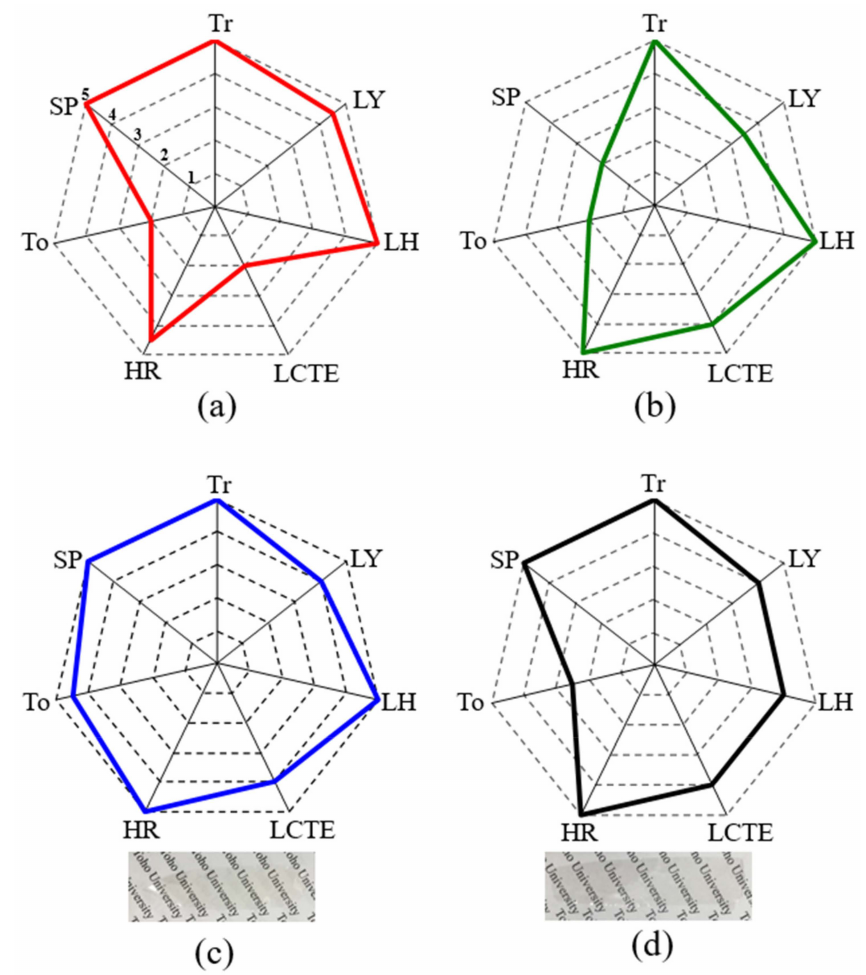
Figure 15. Performance balance of the H-PMDA-based low-CTE PIs obtained in this study and comparative systems: ( a ) H-PMDA/TFMB; ( b ) CBDA/TFMB; ( c ) H-PMDA/AB-TFMB; ( d ) H-PMDA/AMB- m TOL. The criteria and abbreviations of the target properties are shown in Table 5. The inserted photographs show the appearances of the PI